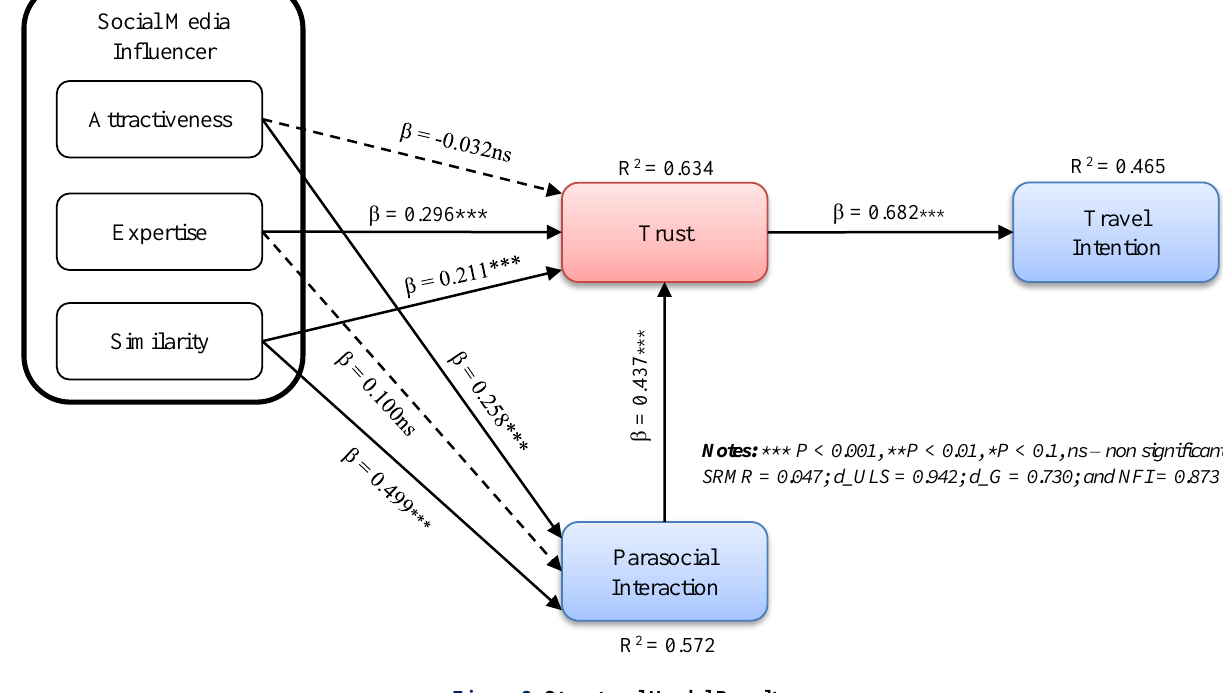
Figure 3. Structural Model Results